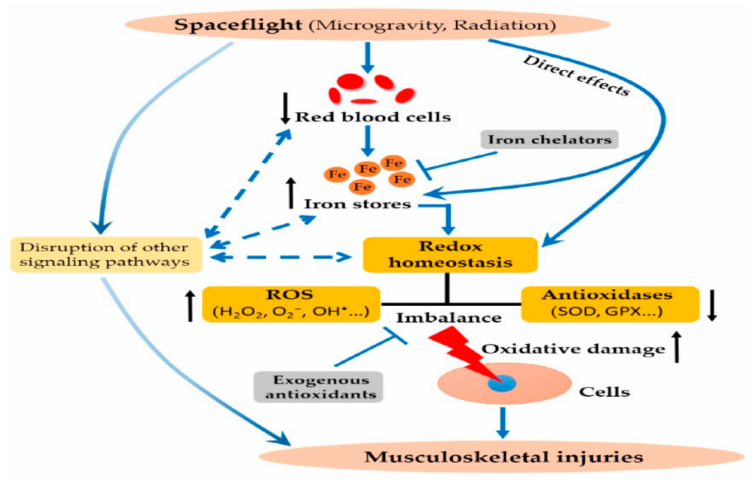
Figure 2. Credit to